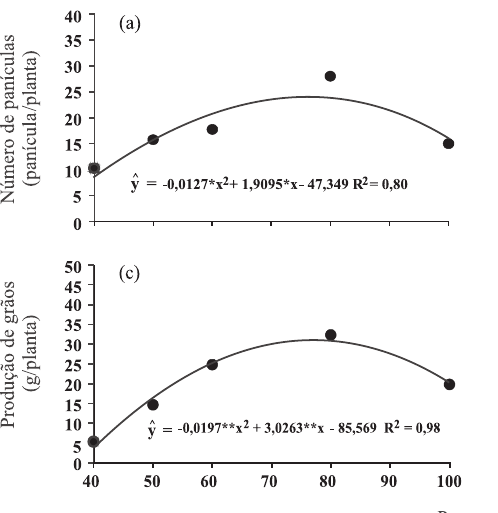
figura 2. número de panículas por planta e produção de grãos das cultivares de arroz brs Colosso (a,c) e brsmG Conai (b,d) em função das proporções de nitrato na solução nutritiva. * e ** significativo em níveis de p < 0,05 e p < 0,01,